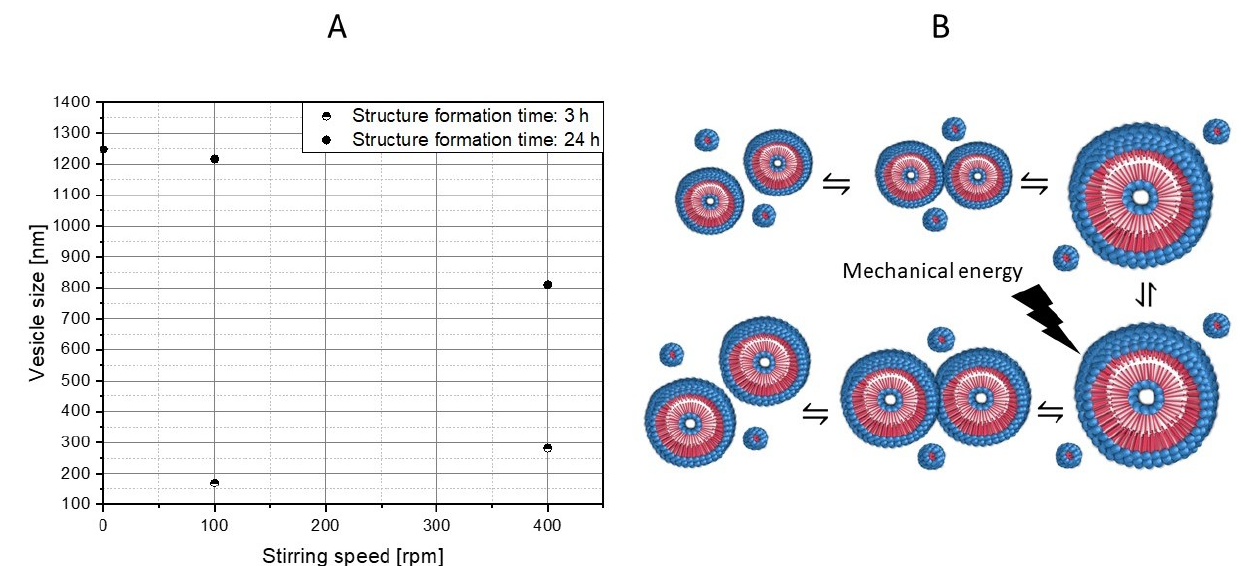
Figure 12. Influence of the stirring speed and the structure formation time on the vesicle sizes of the polymer structures ( A ). Derived ripening processes, as well as behavior of vesicles in the flow ( B ). The hydrophilic part PAA is shown in blue and the hydrophobic part PS of the block copolymer is shown in red.